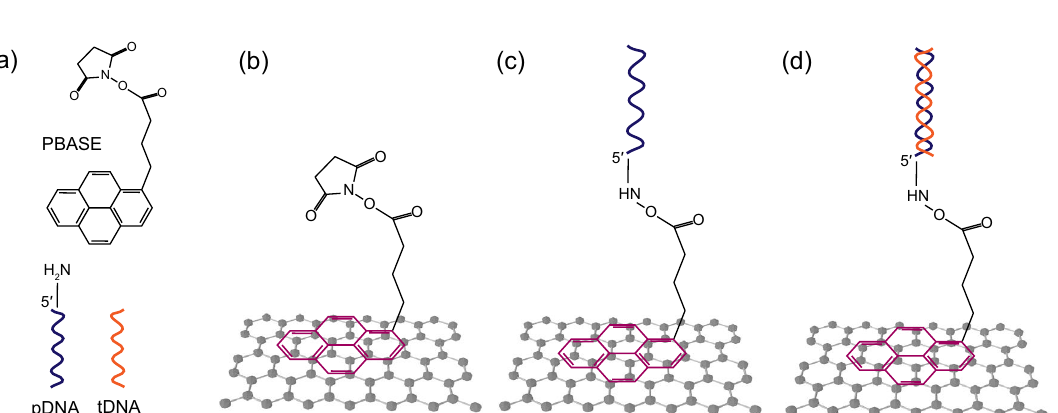
Figure 8. ( a ) Molecular structure of PBASE, and conceptual drawing of probe DNA (pDNA) and complementary target DNA (tDNA). ( b ) Noncovalent binding of PBASE to graphene via π–π interaction. ( c ) Immobilisation of pDNA via conjugation reaction with the succinimide group of PBASE. ( d ) pDNA-tDNA